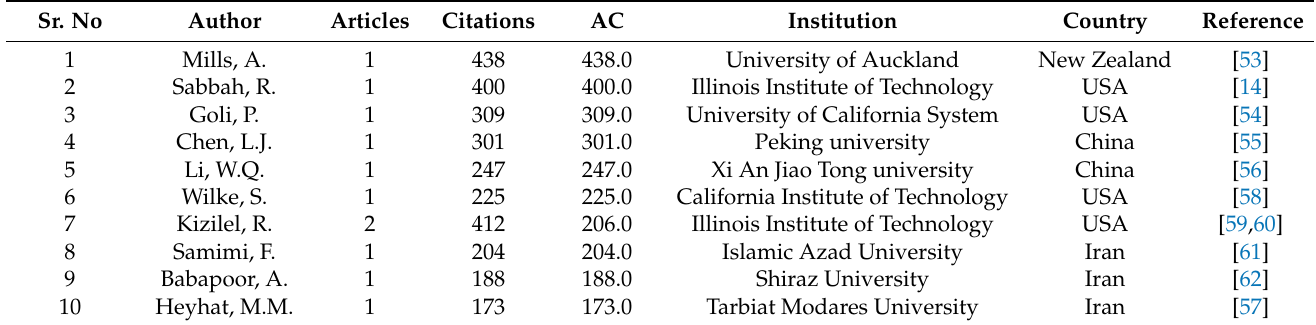
Table 5. Top 10 authors with more average citations in the research